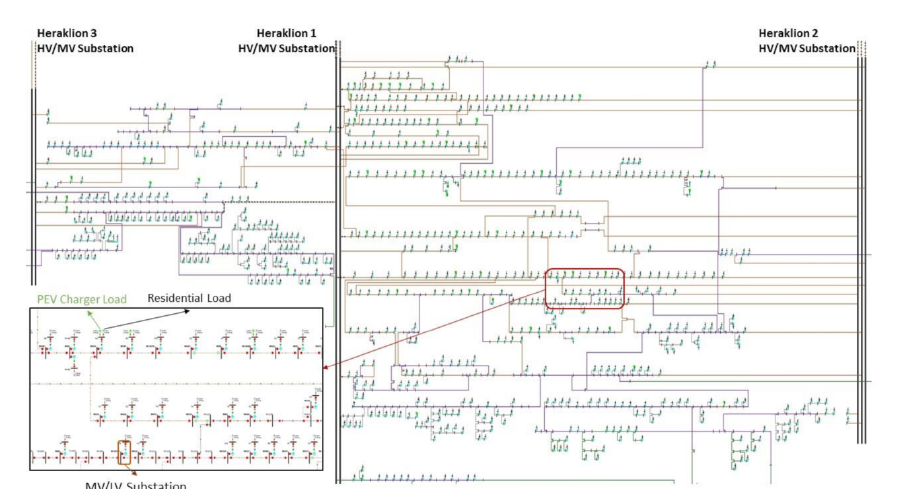
Figure 1. Single-line diagram of the distribution grid of the city of Heraklion.